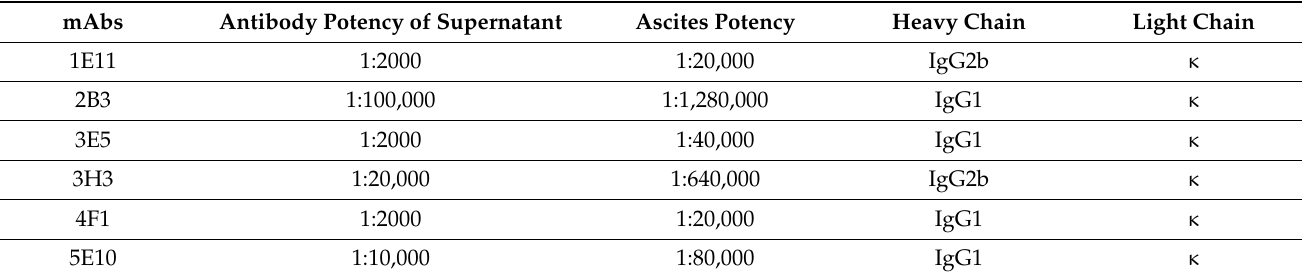
Table 3. Monoclonal antibody isotype identification and antibody